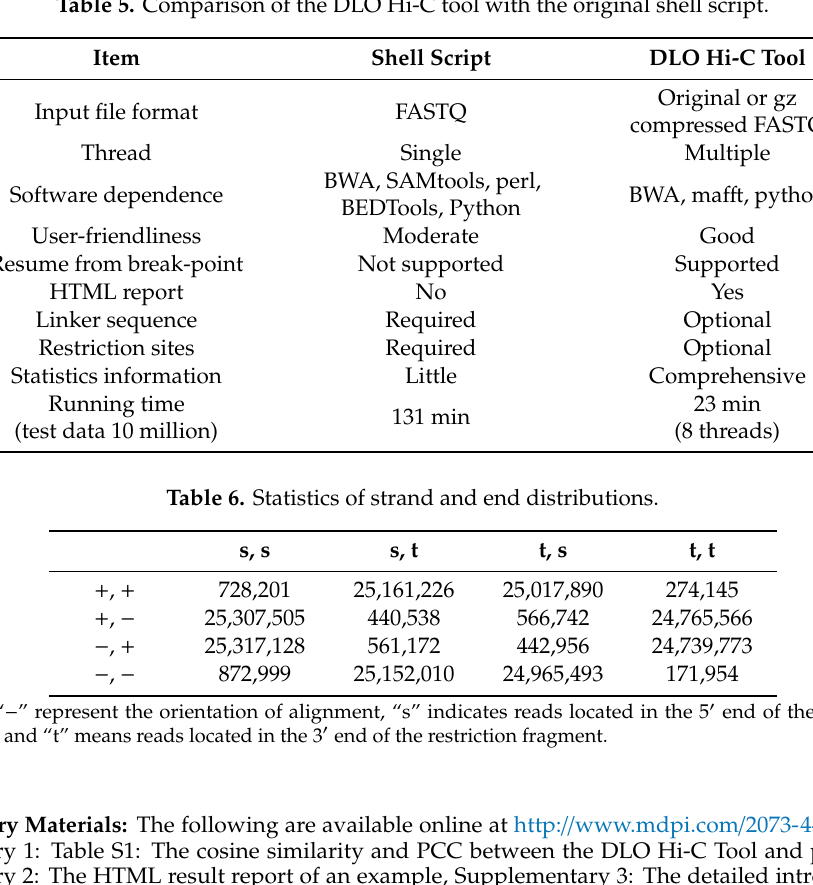
Supplementary 1: Table S1: The cosine similarity and PCC between the DLO Hi-C Tool and published data, Supplementary 2: The HTML result report of an example, Supplementary 3: The detailed introduction to the HTML results, Supplementary 4: Detailed introduction of the DLO Hi-C Tool (Python